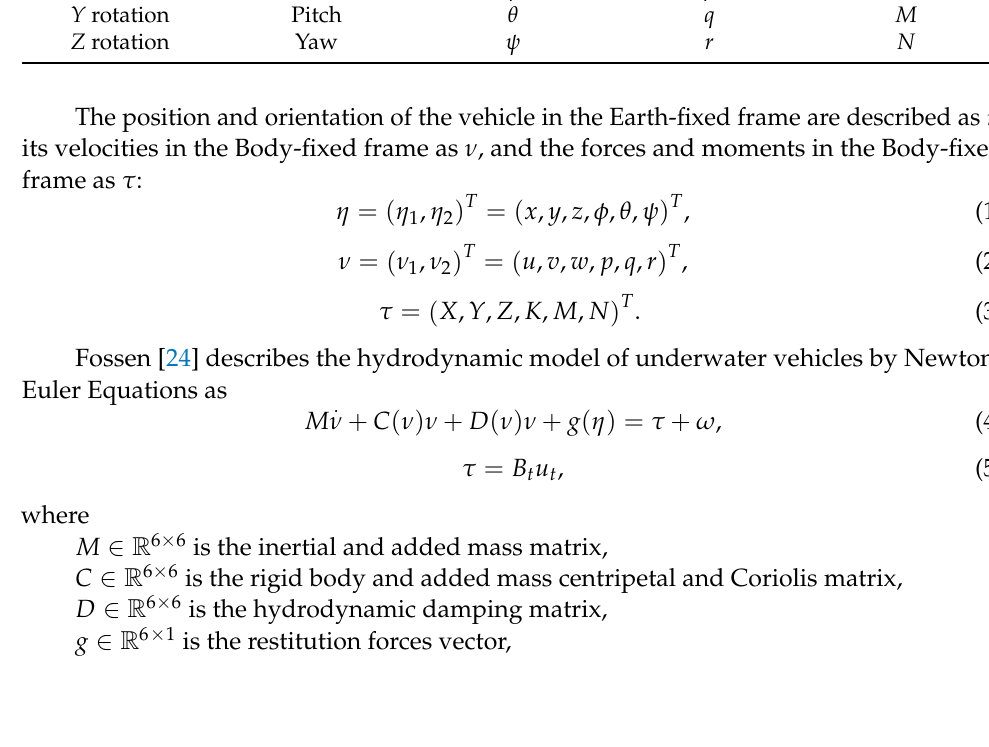
Table 1. SNAME notation for underwater vehicles.